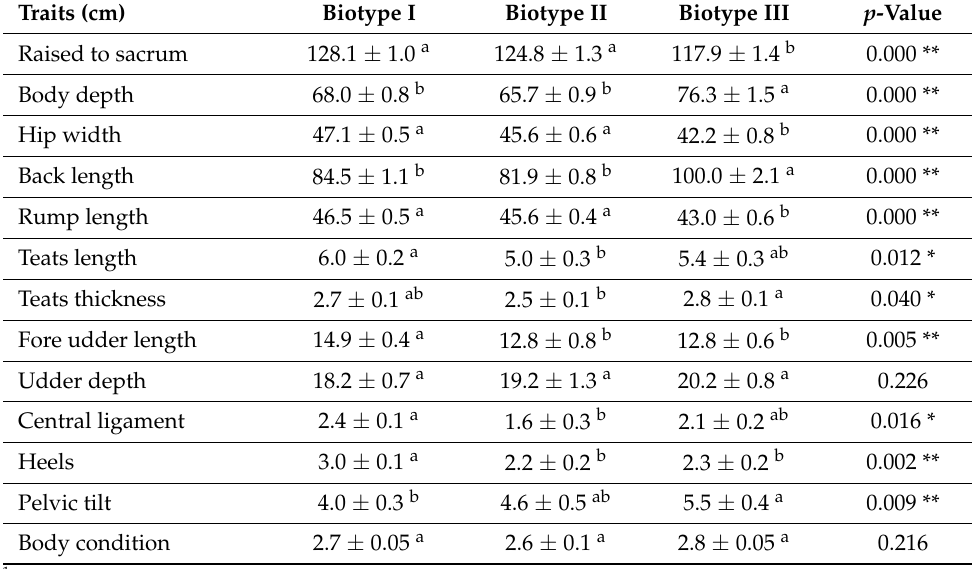
Table 1. Quantitative traits of Creole cow biotypes from Amazonas region, Peru 1 .